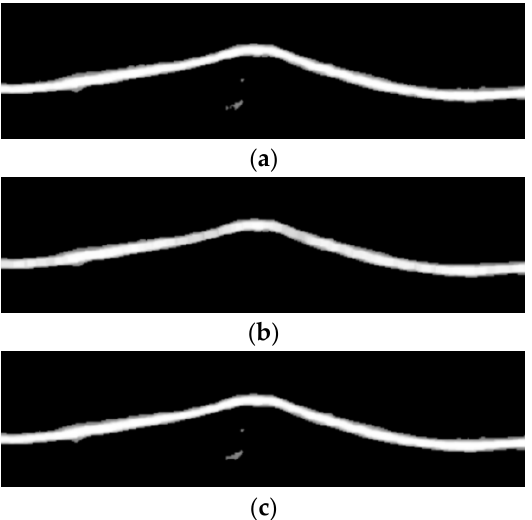
Figure 3. Morphological processing of the filtered image: ( a ) represents the original image, ( b ) represents the open operation of the image, ( c ) represents the closed operation of the image.